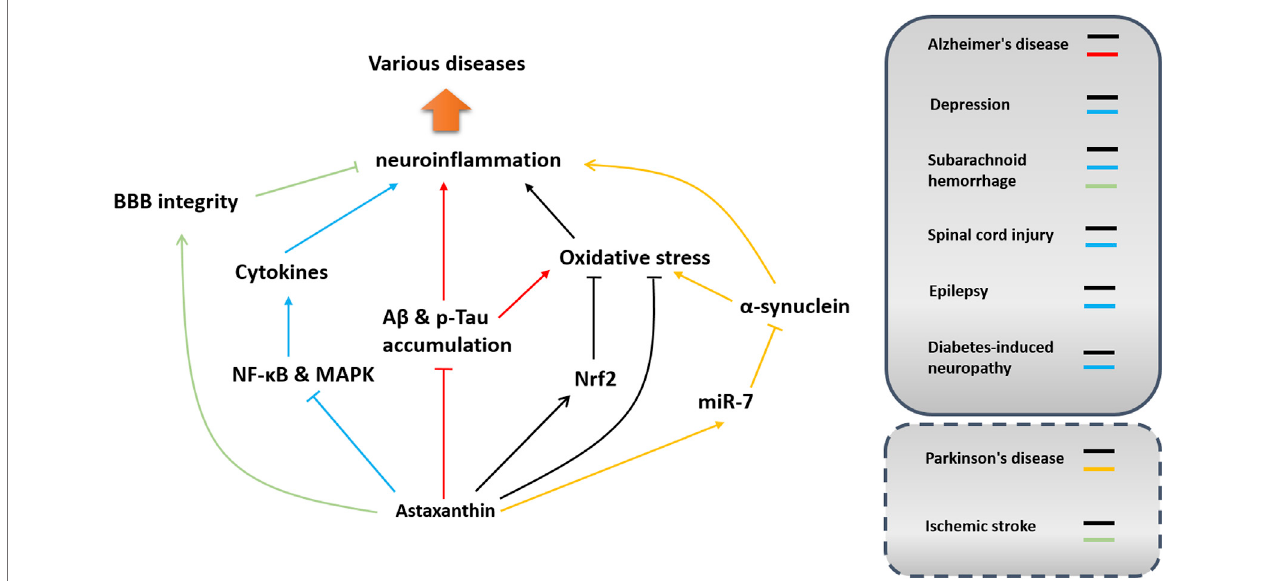
FIGURE 5 | Implications and potential mechanisms of astaxanthin in neuroin fl ammation-associated disorders. Potential pathways involved in neuroin fl ammation modulation in different disease models are depicted in different colors. Arrows indicate acceleration or promotion, while lines with T-shaped ends represent inhibition or blocking. Dashed boxes indicate that the function of astaxanthin in modulating neuroin fl ammation has not been con fi rmed in these diseases.